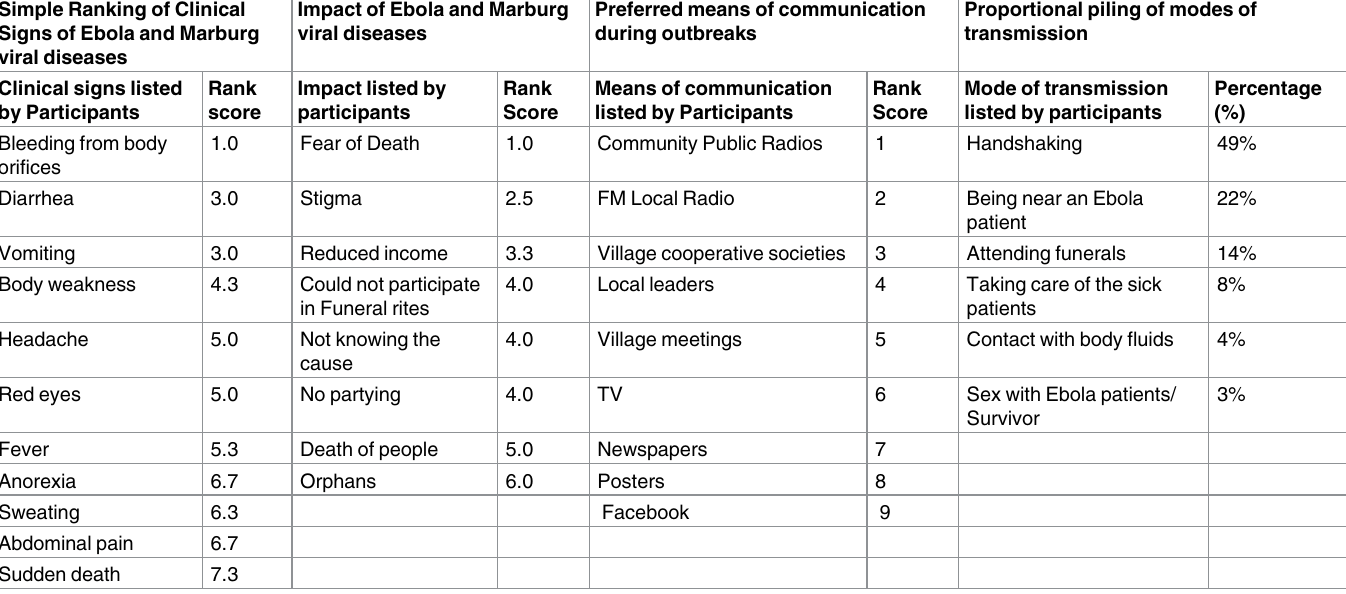
Table 5. Results of simple ranking and proportional piling as listed and ranked by five FGD participants. Simple Ranking of Clinical Signs of Ebola and